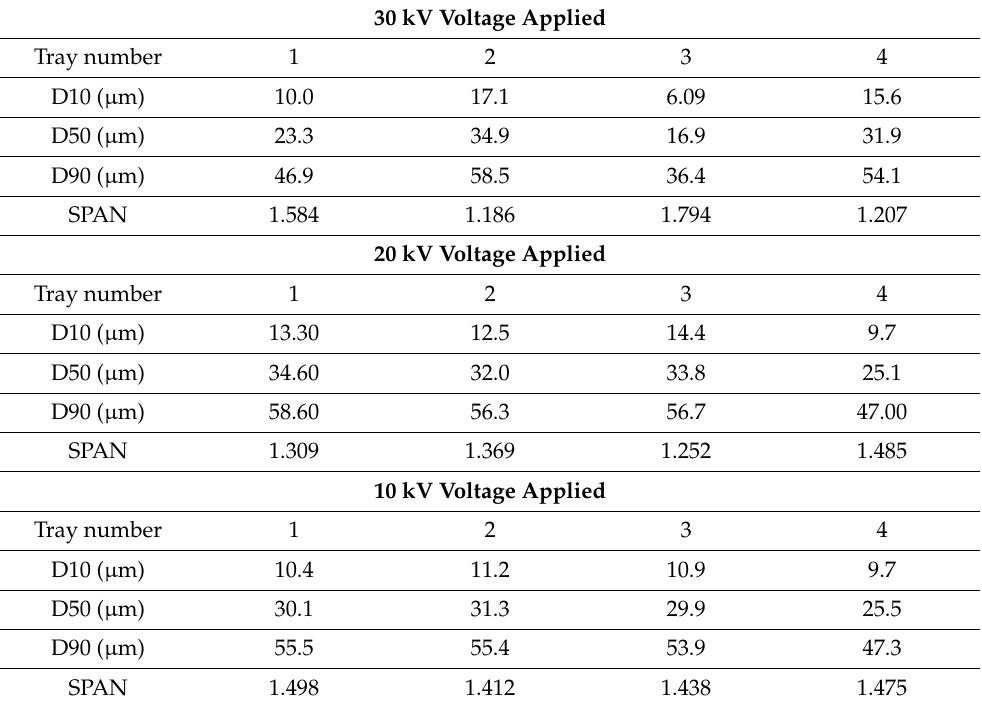
Size distribution of ASP-30 powder after separation using the ELKOR unit with different